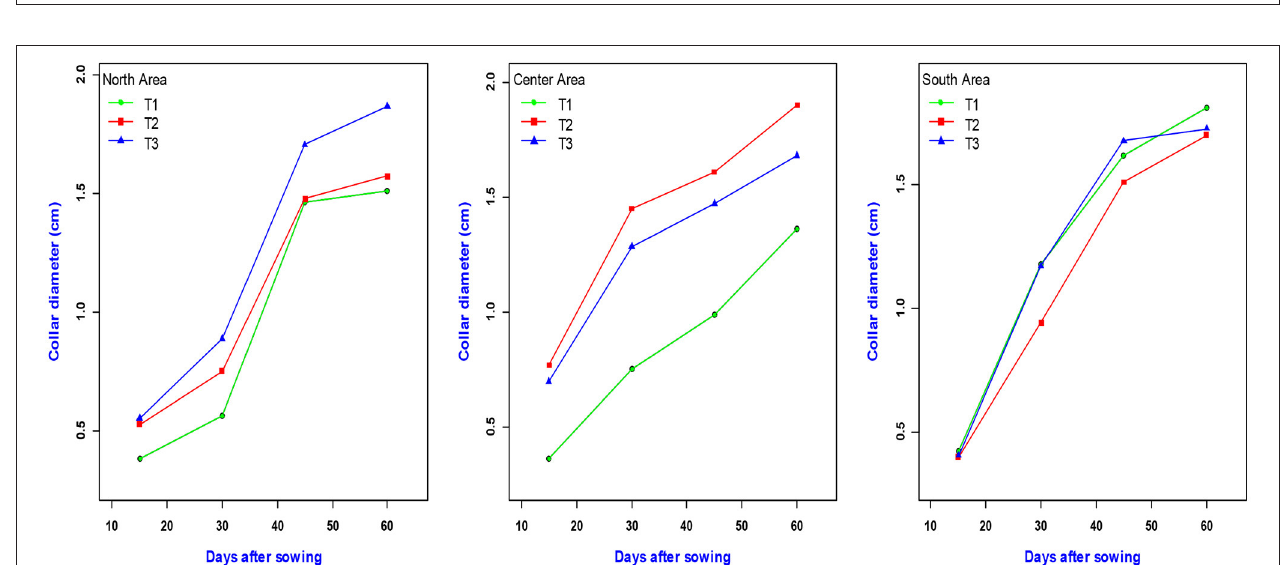
FIGURE 3 | Variation in collar diameter as a function of different treatments and study areas.